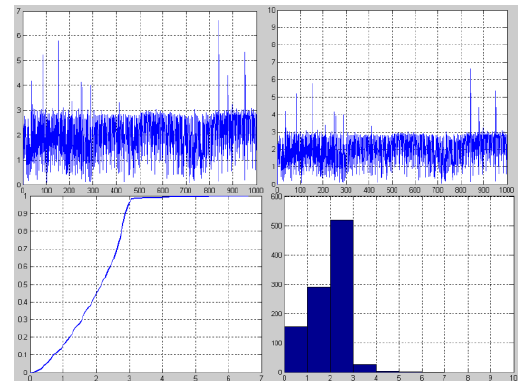
Figure8. horizontal direction of error statistics about the integrated positioning under EKF